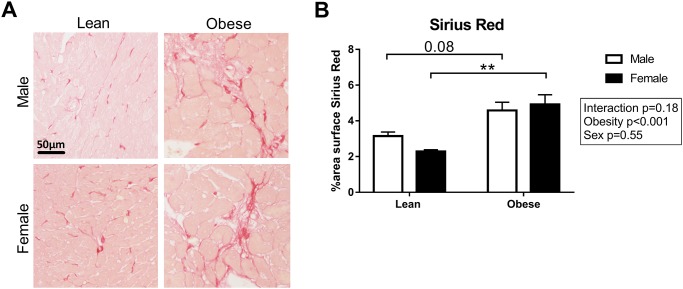
Increased fibrosis observed in obese ZSF1 rats.A) Representative images and B) quantification of histological staining of cardiac collagen fibers stained with Picro Sirius Red. N = 4-7/group. **P<0.01.